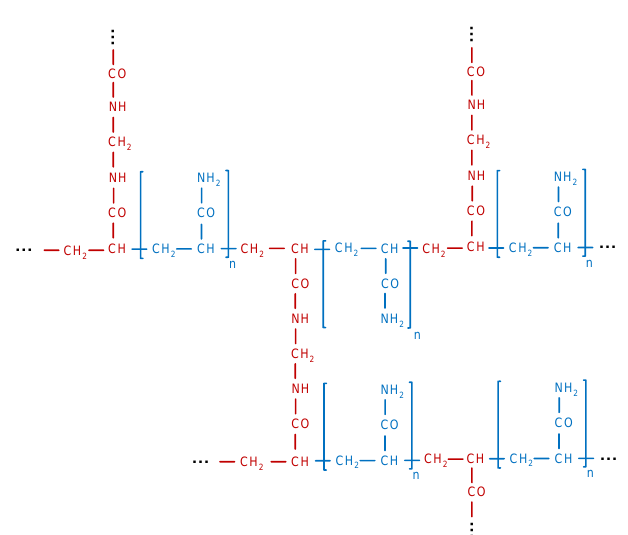
Figure 2. Cross-linked PAM (red = methylenebisacrylamide, blue = PAM) (modified after National Diagnostics [45]).